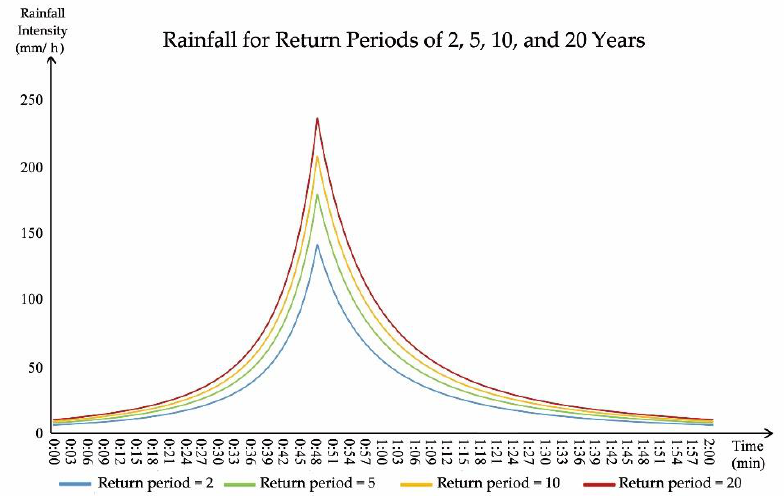
Figure 4. Rainfall Hydrograph for Nanjing with Return periods of 2, 5, 10 and 20 years.